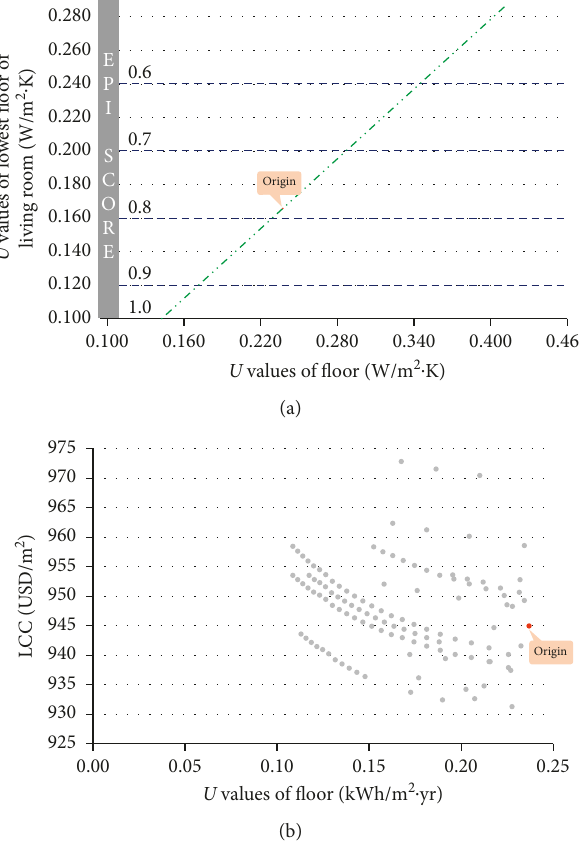
Primary energy consumption for Figure 9: LCC according to the primary energy use for the U values of the floors.